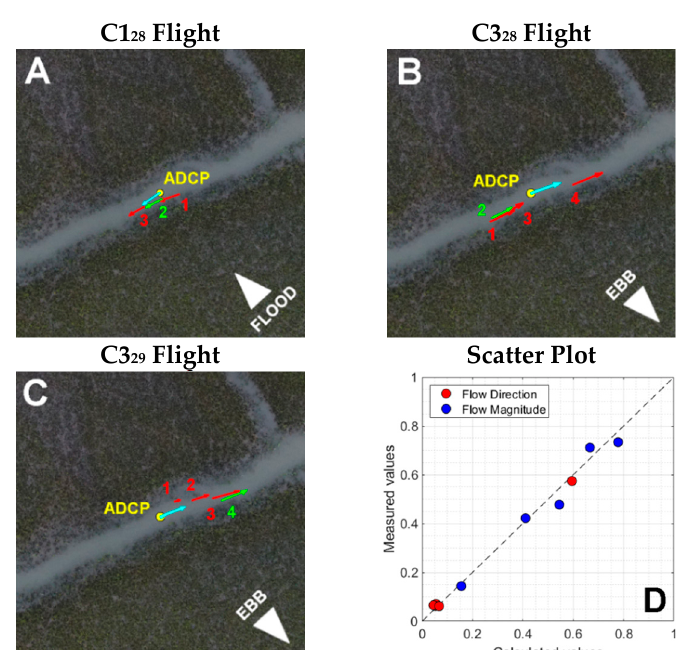
Figure 7. ( A–C ) Planar view of surface velocity vectors computed with our algorithm (red and green arrows) and surface velocities measured with the ADCP (blue arrow) during the flights performed to survey the creeks. The green arrows indicate velocities computed from the clouds that were compared with the velocity measured by the ADCP. ( D ) Comparison between dye-derived and ADCP-derived velocities (magnitude and direction). In order to have them both ranging between 0 and 1, flow velocities are made dimensionless with the max magnitude measured by the ADCP over the 2 days (0.9 m/s), and directions are divided by 360°. Table 7. Surface water flow velocity and direction measured using an ADCP and calculated using dye clouds detected by our image processing algorithm. For the velocity, the relative and absolute errors are reported. For the direction, only the absolute error is reported. The direction was measured in degrees from the east (counterclockwise).